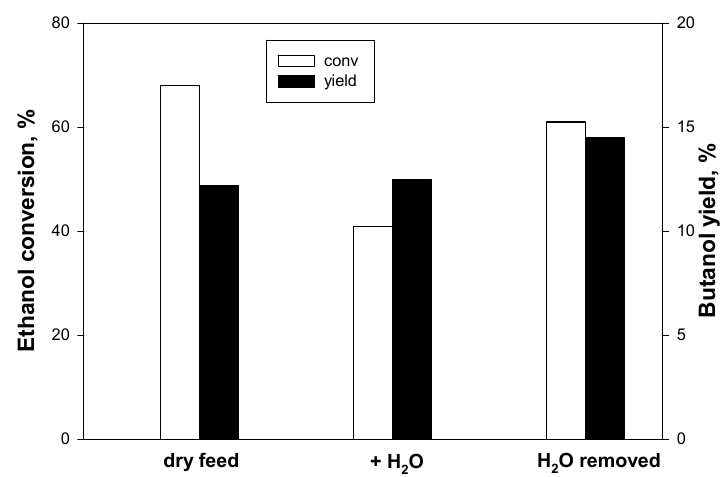
Figure 6. Effect of 2 vol. % H 2 O addition to the feed (for a total of 9 h) and removal on the ethanol conversion and butanol yield obtained with a 20%MgO/AC sample tested at T = 400 °C and GHSV = 330 h − 1 .